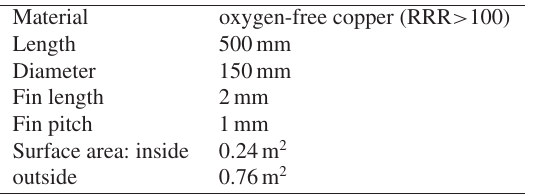
Table 1. Heat exchanger parameters.